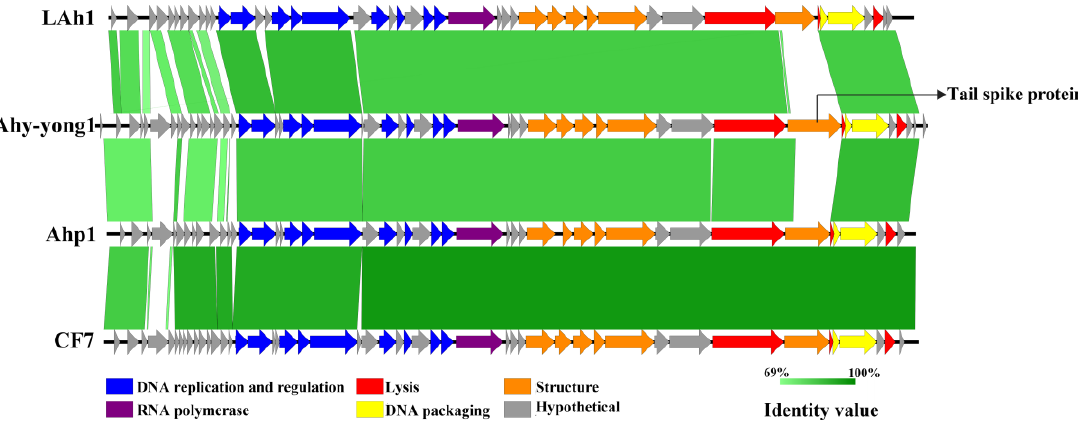
Figure 6. Genome comparison of the Aeromonas phage Ahy-yong1 and the three closest relatives ( Aeromonas phage LAh1, Aeromonas phage CF7, and Aeromonas phage Ahp1). The orientation of the arrows indicates the direction of gene transcription. The color of each arrow refers to the functional categories: blue indicates DNA replication and regulation; yellow indicates DNA packaging; red indicates lysis; orange indicates structure; purple indicates RNA polymerase; gray indicates hypothetical protein. The homologous regions are represented by green bars. Light green to dark green represent low to high homology between genes.